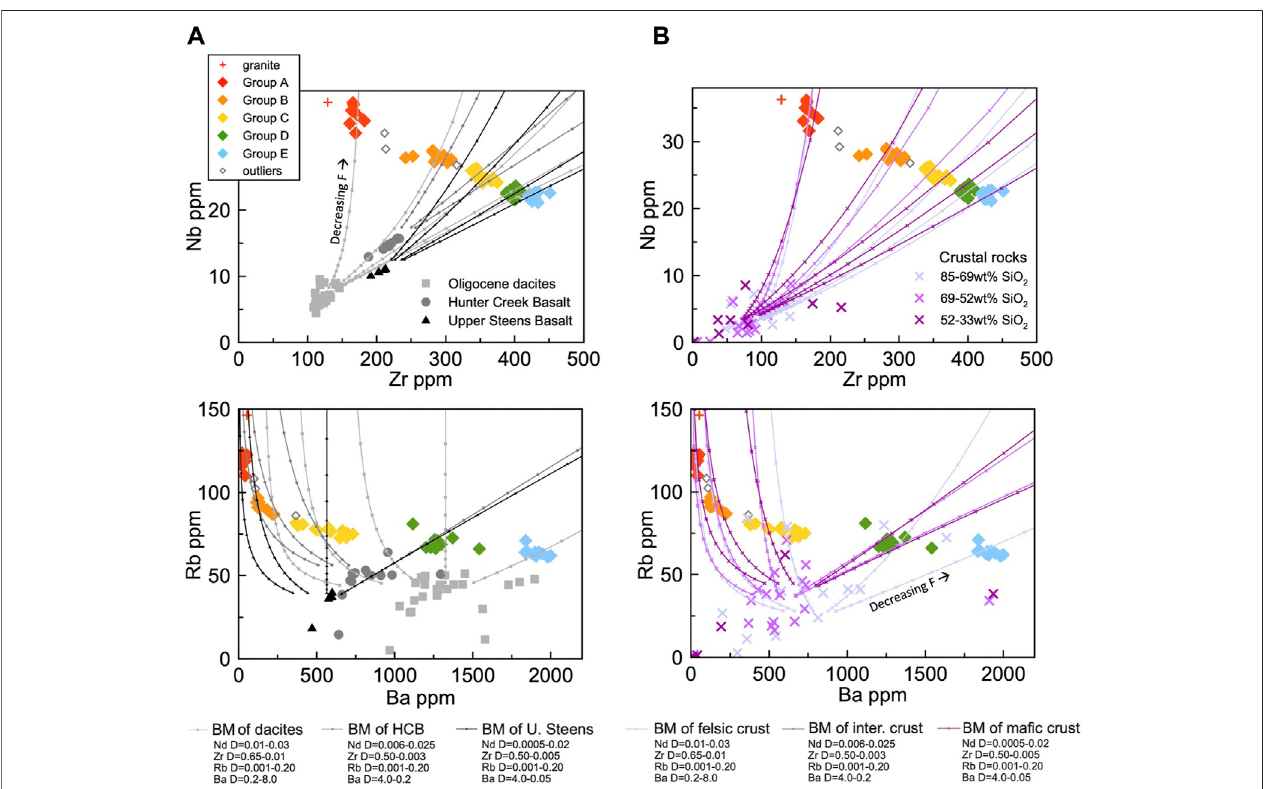
FIGURE 14 | Batch melting modeling of various rocks that reside within the crust around the Rattlesnake Tuff magma storage system to determine whether individual high-silica rhyolite Groups can form independently from each other rather than as a liquid line. D values for each element were manipulated until a composition ofaHSRGroupwasachieved.Melt fraction (F)foreach modelranges from0.85to0.05inincrements of0.05. (A) Batch melting ofregionalOligocenedacites(Isomand Streck, 2016; Cruz and Streck, 2017; Streck, unpub. data), Hunter Creek Basalt (Webb et al., 2018), and Upper Steens Basalt (Moore et al., 2018). (B) Batch melting of various regional crustal and terrane rocks, divided by felsic, intermediate, and ma fi c (Steiner and Streck, 2013; Streck, unpub. data).